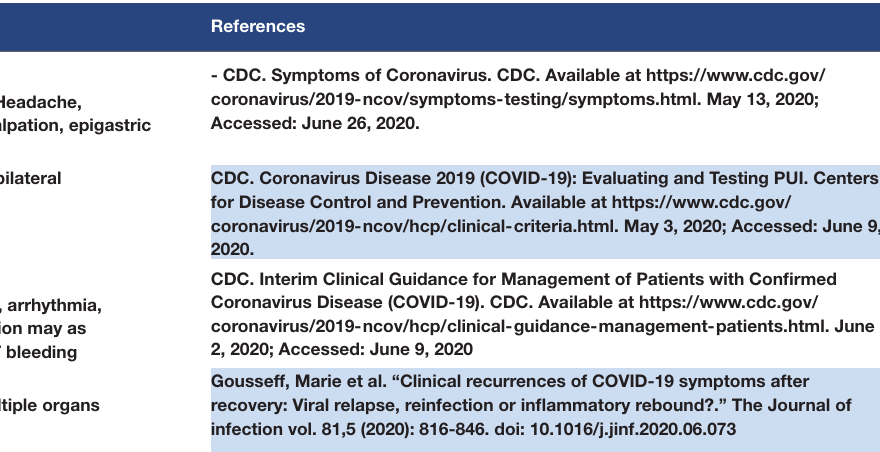
TABLE 16 | The initial manifestations [symptoms] of COVID